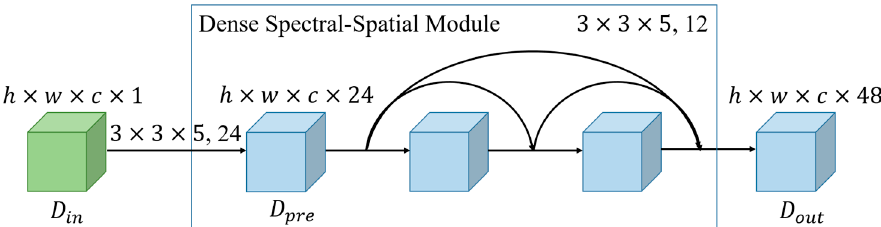
Figure 3. Dense spectral–spatial module.